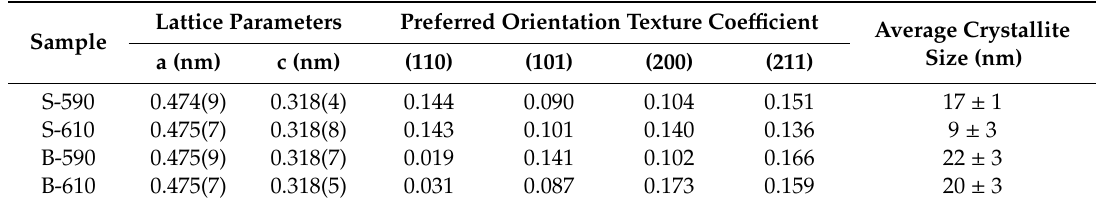
Table 2. Results of GIXRD analysis for SnO 2 samples: lattice parameters (a, c), texture coe ffi cients for four most intense peaks (calculated using Equation (2)), and average crystallite size (calculated using Equation